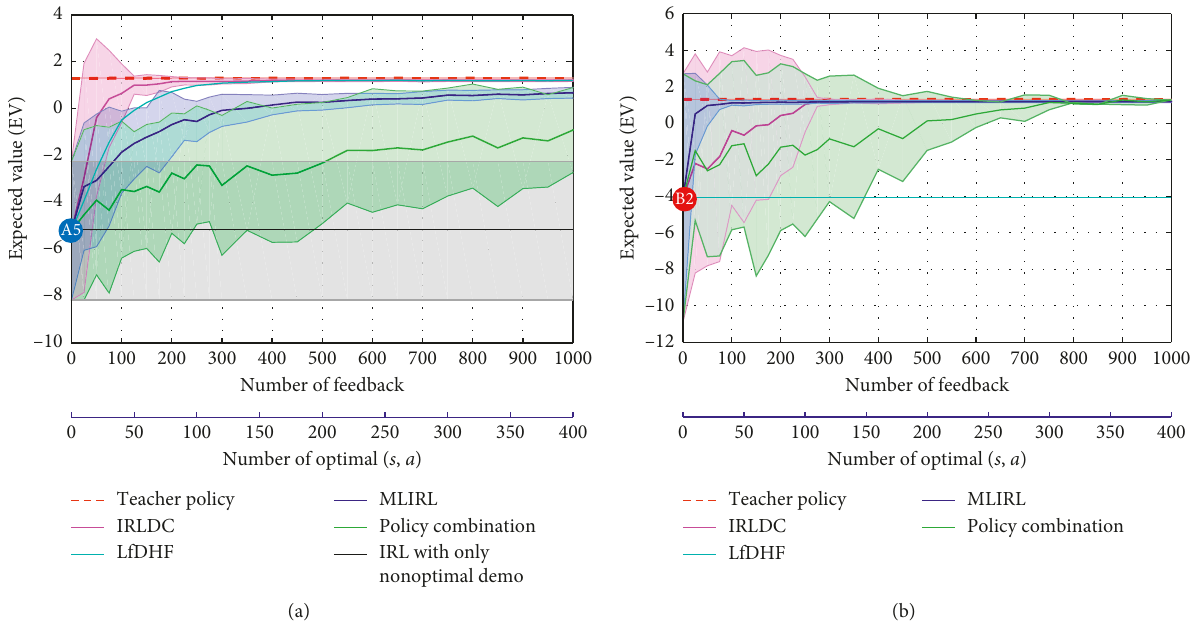
Figure 4: (a) The effect of nonoptimality in demonstrations. The experiment setting: initial nonoptimal demonstration “A5” with 60% optimality and 100 demonstrations in the first stage (see Figure 3). (b) The case where all demonstrations in the first stage are optimal but sparse. The experiment setting: initial sparse demonstration “B2” and 20 demonstrations in the first stage (see Figure 3). Two kinds of data are provided during the experiment: evaluative feedbacks related to the IRLDC, LfDHF, and policy combination (first horizontal axis), and state-action pairs in extraoptimal demonstrations used in the MLIRL (second horizontal